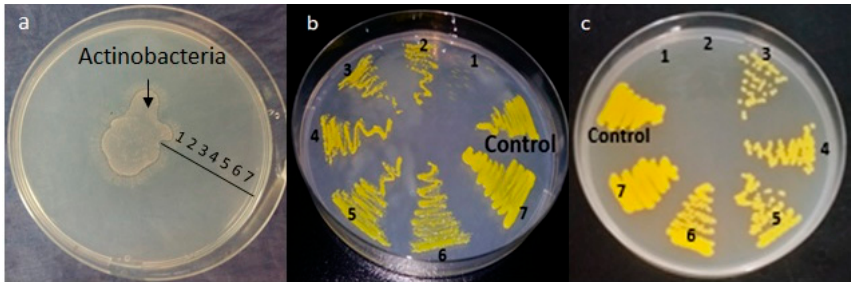
Figure 3. Impact of Actinobacteria on M. luteus viability. Pure culture growth of predatory Actinobacteria in the presence of washed live cells of M. luteus as the sole source of nutrients on agar-agar medium ( a ). Transplanted viable M. luteus prey cells present at various distances from Actinobacteria after 24 h ( b ) and 48 h ( c ) of incubation.